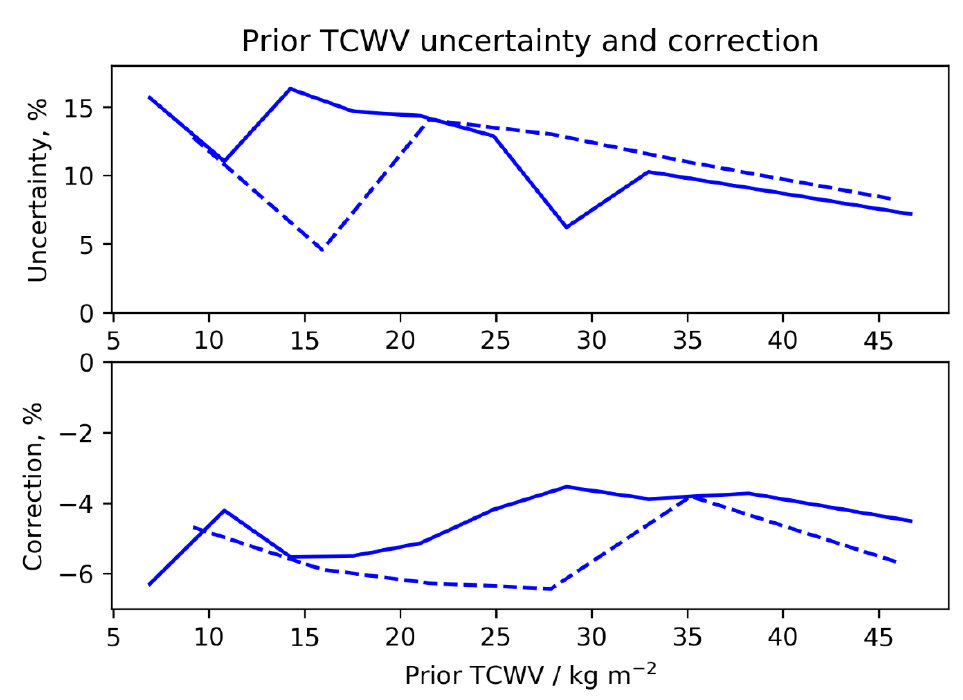
Figure 2. Parameters for optimal estimation related to total column water vapor (TCWV), estimated per TCWV decile from harmonization of MTA to AATSR (solid lines) and SLSTR-A (dashed lines). Upper panel: prior TCWV uncertainty estimate, in percent. Lower panel: bias correction to be added to prior TCWV.